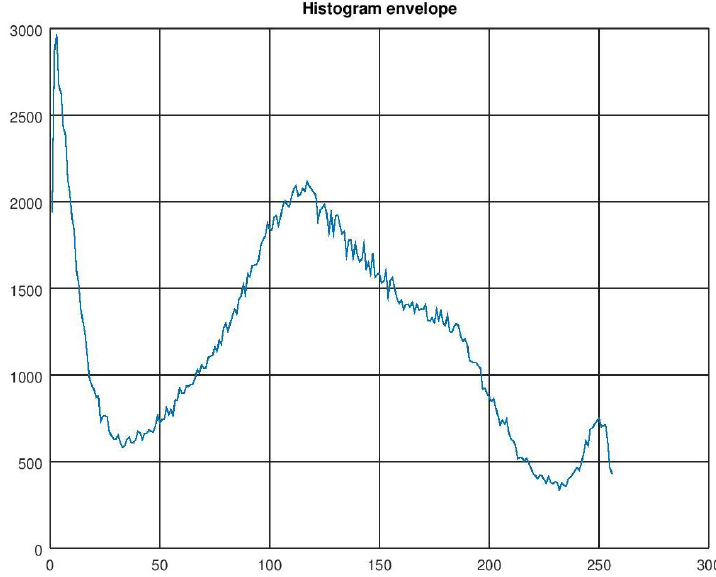
Figure 12. Histogram envelope.